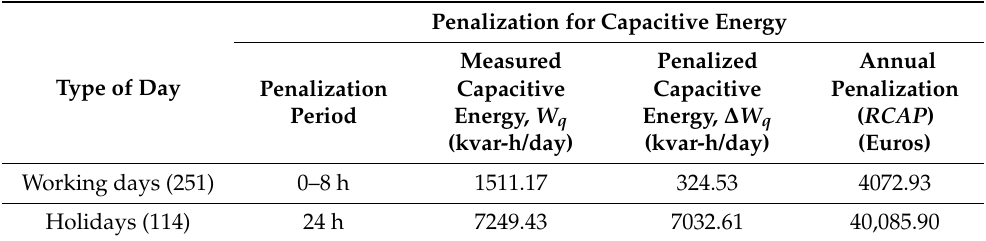
Table 6. Measured and penalized capacitive energies each day and annual penalizations.